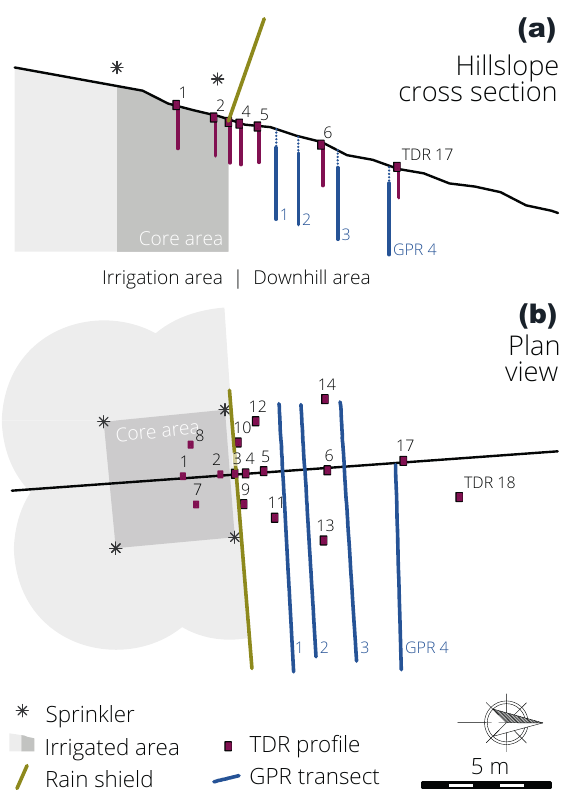
Figure 3. Layout of the hillslope-scale irrigation experiment as ver- tical view (a) and plan view (b) . The hillslope is divided into an irrigation area and a downhill area by a rain shield. Sixteen access tubes for TDR measurements of soil moisture profiles are arranged in three diverting transects. Parallel to the contour lines, four tran- sects of 2-D time-lapse GPR are